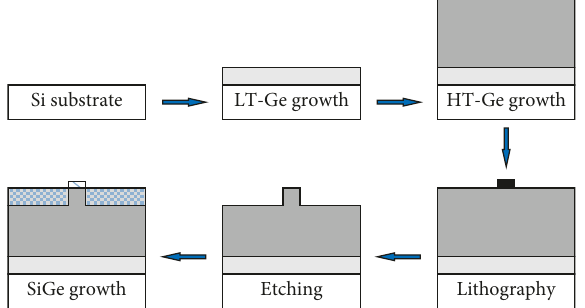
Figure 6: Preparation process of direct band gap Ge scheme compatible with the Si process.